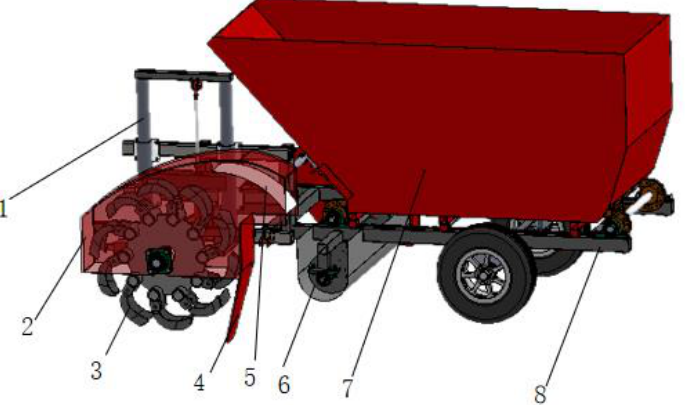
Figure 1. General structure of soil and fertilizer collision mixing and mulching device. 1. lifting frame, 2. guide cover, 3. ditching mechanism, 4. trench cleaning plate, 5. Soil dividing plate, 6. Auger, 7. fertilizer box, 8. frame.